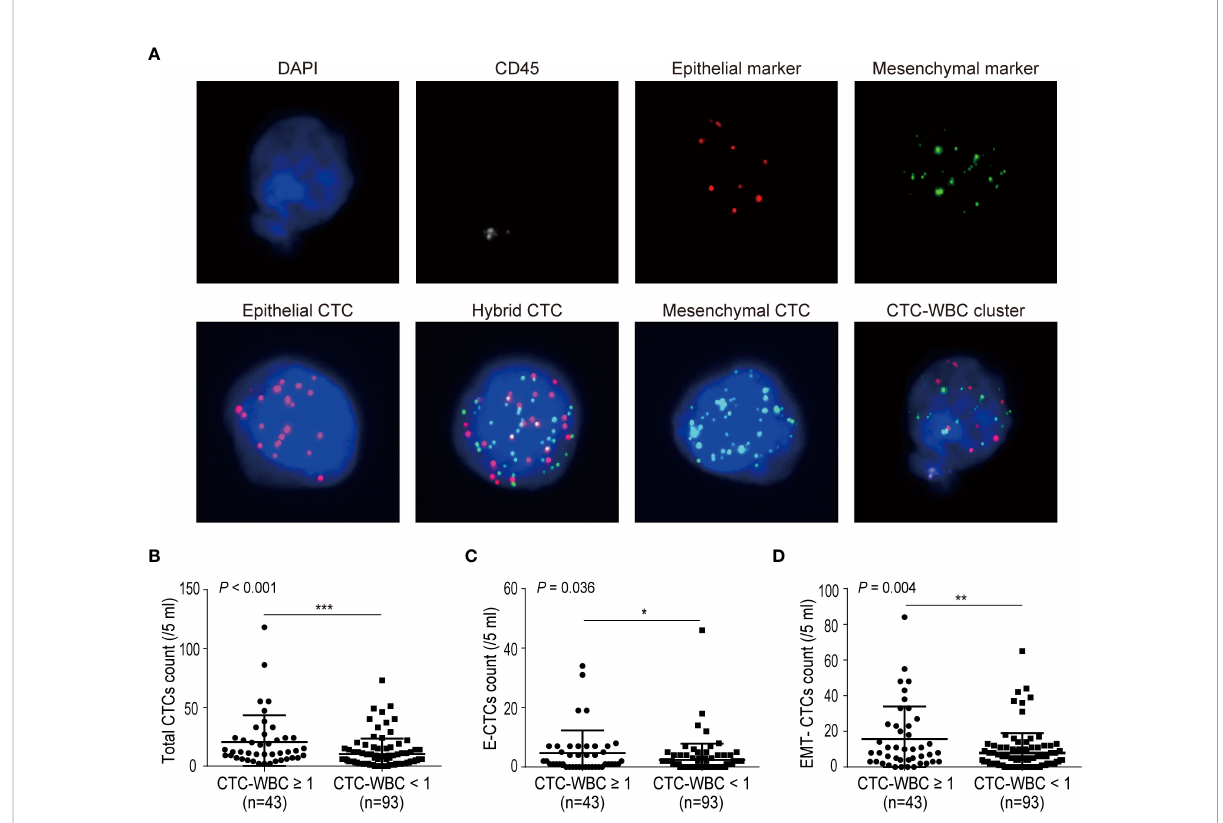
FIGURE 1 Correlations between the number of CTC-WBC clusters and single CTC parameters (total CTCs, E-CTCs, and EMT-CTCs). (A) Images of CTCs (EMT phenotypes) and CTC-WBC cluster. CTCs and CTC-WBC clusters were identi fi ed by epithelial and mesenchymal markers. CD45 signal was served as WBC marker and DAPI was used for nuclear staining. (B – D) Comparison of total CTCs number (B) , E-CTCs number (C) , and EMT- CTCs number (D) in different CTC-WBC cluster groups (positive or negative). *P <0.05, **P <0.01 and ***P